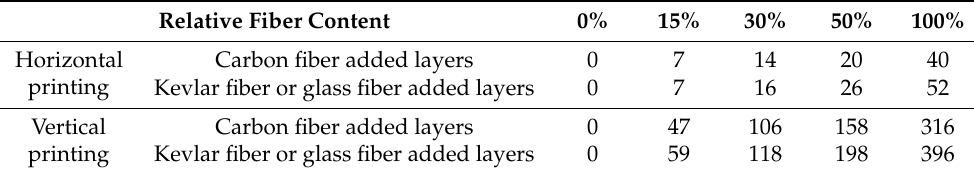
Table 2. The designed printed composites for